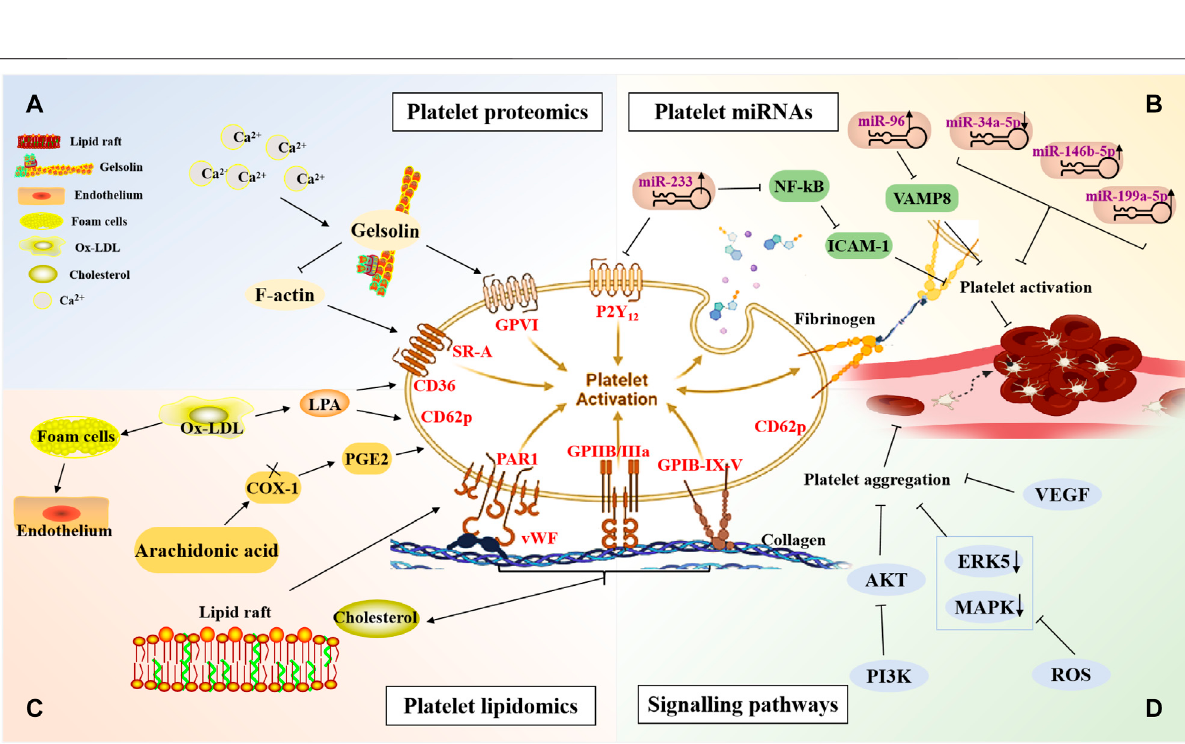
Frontiers in Pharmacology |